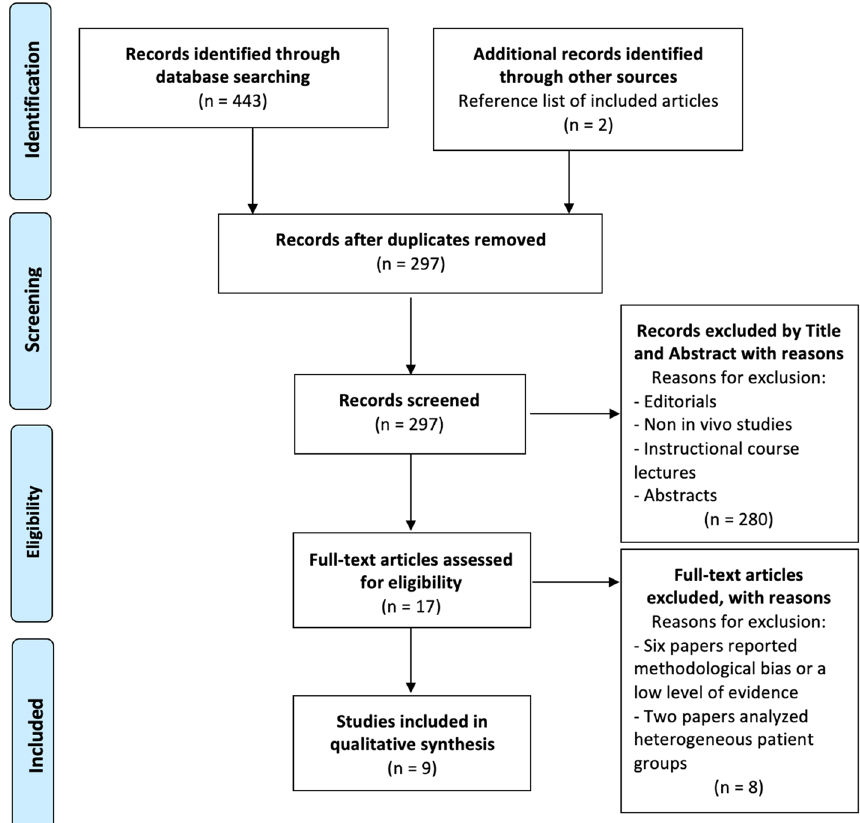
Fig. 1 Preferred reporting items for systematic review and meta-analysis (PRISMA) flow diagram of studies included in the systematic